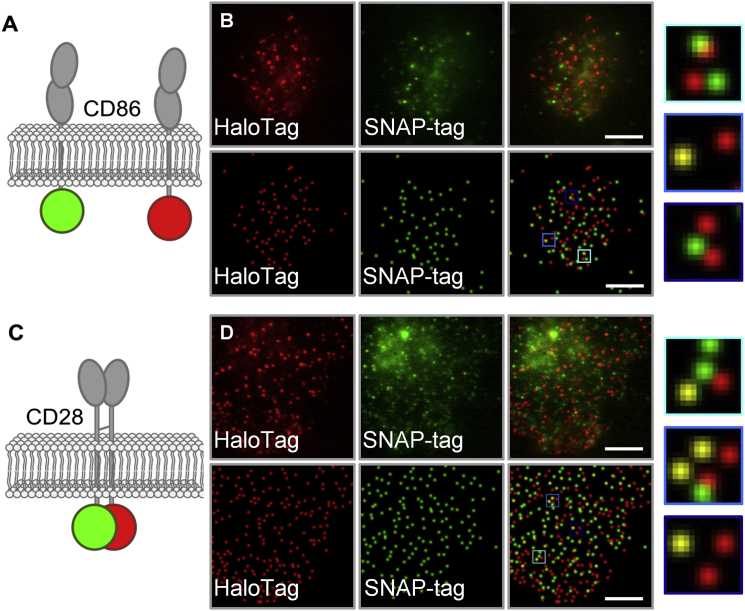
Principle of referenced colocalization exemplified for CD86 and CD28 controls expressed in HEK-293T cells. (A) Representation of transfected HaloTag- (red) and SNAP-tag (green)-labeled monomeric CD86 protein. (B) Representative data obtained for CD86 in the green and red channels showing raw data (top row) and reconstructions of spot detection after application of the tracking algorithm (bottom row). Blue-boxed regions are shown magnified at far right. (C) HaloTag- (red) and SNAP-tag-labeled (green) dimeric CD28 protein. (D) Representative raw and reconstructed data obtained for CD28 showing higher levels of coincidence. Scale bars are 5 μm.